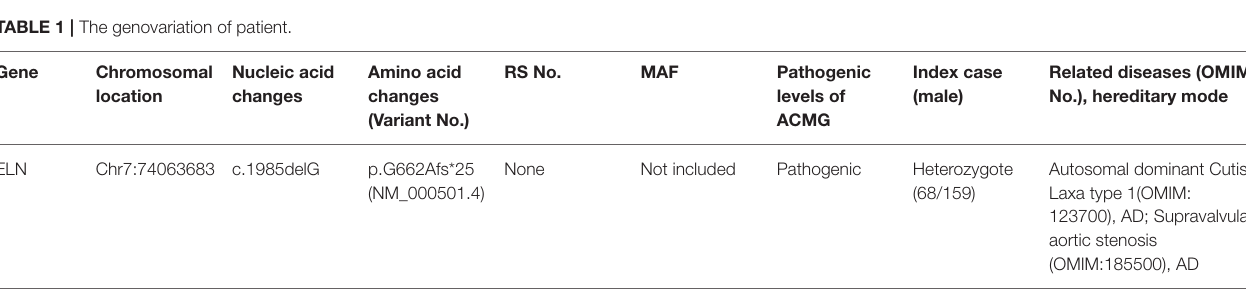
TABLE 1 | The genovariation of